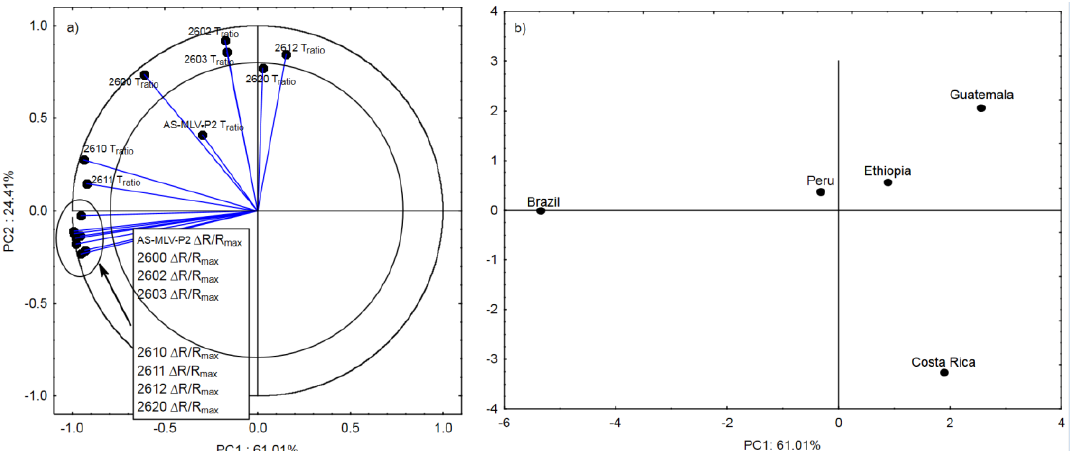
Figure 5. Loading plot (a) and score plot (b) of the principal components analysis carried out for sixteen sensor readings and types of coffee from Brazil, Ethiopia, Guatemala, Costa Rica, and Peru